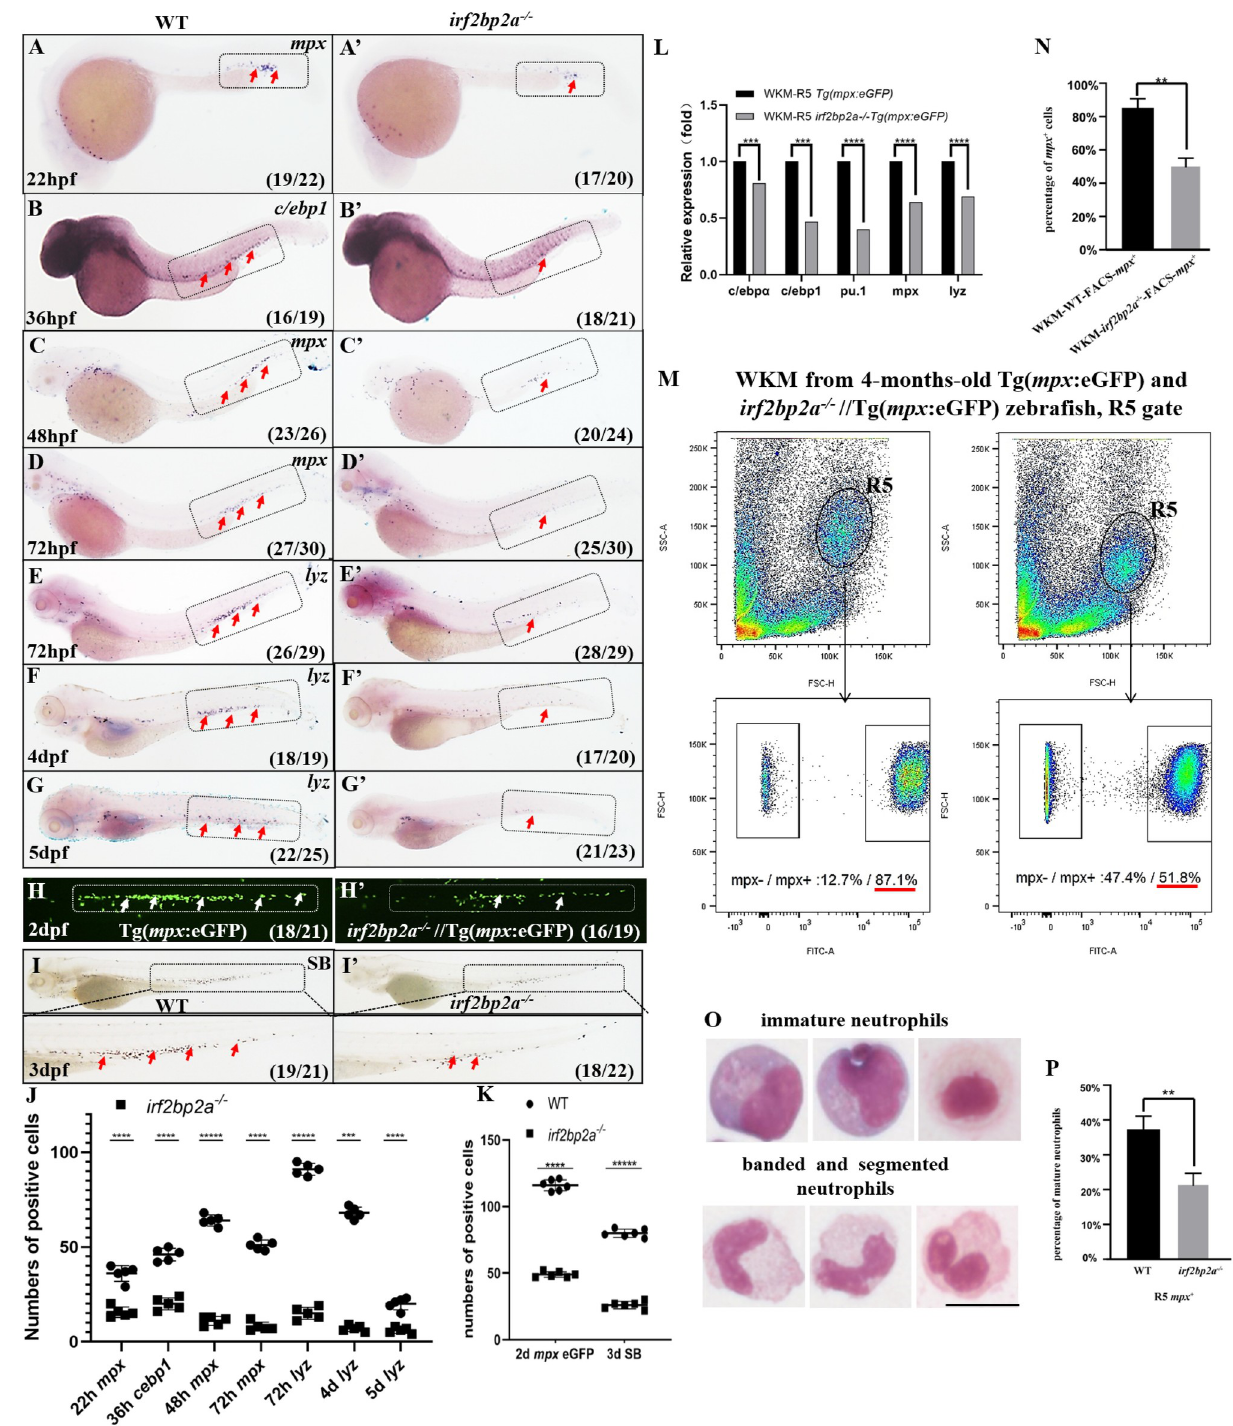
Fig 2. Deficiency of irf2bp2a specifically impairs neutrophils maturation in embryonic and adult zebrafish. (A-G’) WISH analyses of neutrophils markers mpx (A, A’, C-D’), c/ebp1 (B, B’), lyz (E-G’) from 22 hpf to 5 dpf in wild type (WT) and irf2bp2a -deficient embryos. Grey boxes and red arrows indicate the main position of positive cells for each marker. n/n, number of embryos showing representative phenotype/total number of embryos examined. (H, H’) GFP positive cells are decreased in irf2bp2a -/- // Tg(mpx : eGFP) embryos at 2 dpf. (I, I’) Sudan Black positive cells are reduced in irf2bp2a -deficient embryos at 3 dpf. (J) Statistical results for A-G’ (Student t test, N = 5, 16–30 embryos were used for each probe. Each dot represents the mean value of one experiment, which was obtained from the counts of all of the embryos in the same group. Error bars represent mean ± SEM.